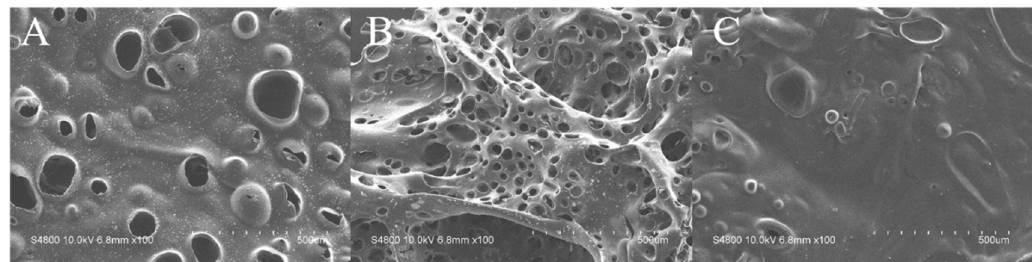
Figure 5. SEM images of char residue obtained from cone calorimeter test: ( A ) TAD0; ( B ) TAD12; and ( C ) TAD6EG6.